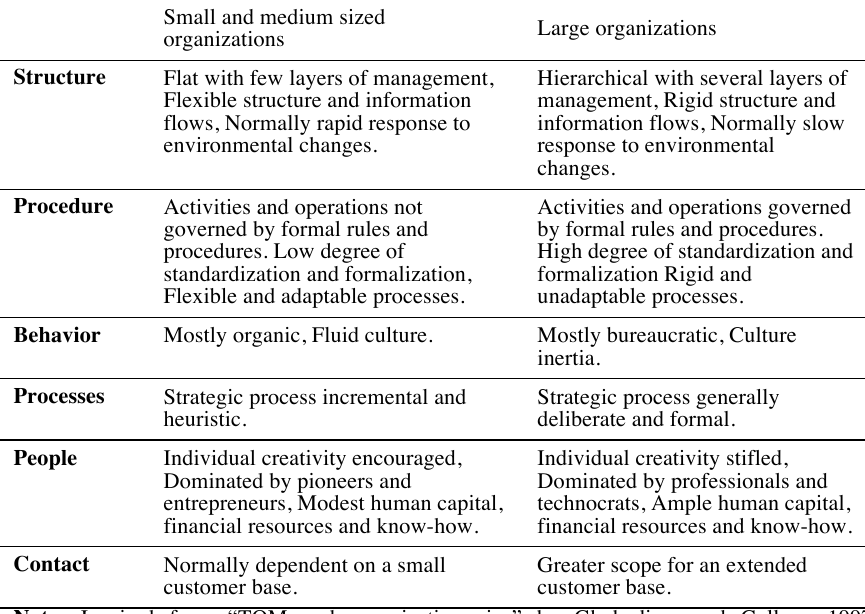
Table 3. Comparison between SMEs and